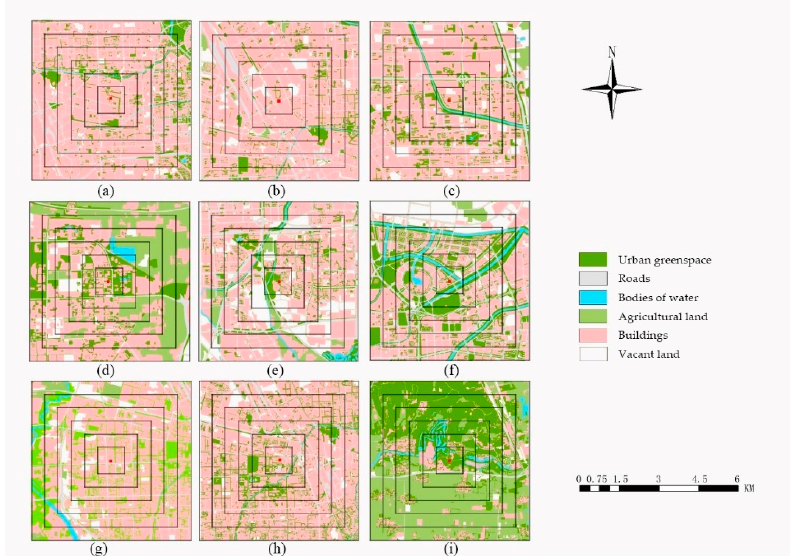
Figure 2. Spatial distribution of different land cover types and multiscale buffers. ( a ) landscape cover types of Yanchang (YC) plot; ( b ) landscape cover types of Heyida (HYD) plot; l ( c ) landscape cover types of Zhengfangji (ZFJ) plot; ( d ) landscape cover types of Shijiancezhan (SJC); ( e ) landscape cover types of Yinhangxuexiao (YHXX) plot; ( f ) landscape cover types of Gongshuigongsi (GSGS) plot; ( g ) landscape cover types of Ganglishuiku (GLSK) plot; ( h ) landscape cover types of Jingkaiquguanwei (JKQ) plot; and ( i ) landscape cover types of Sishiqizhong (SSQ) plot. The red pots in the graph are the locations of monitoring